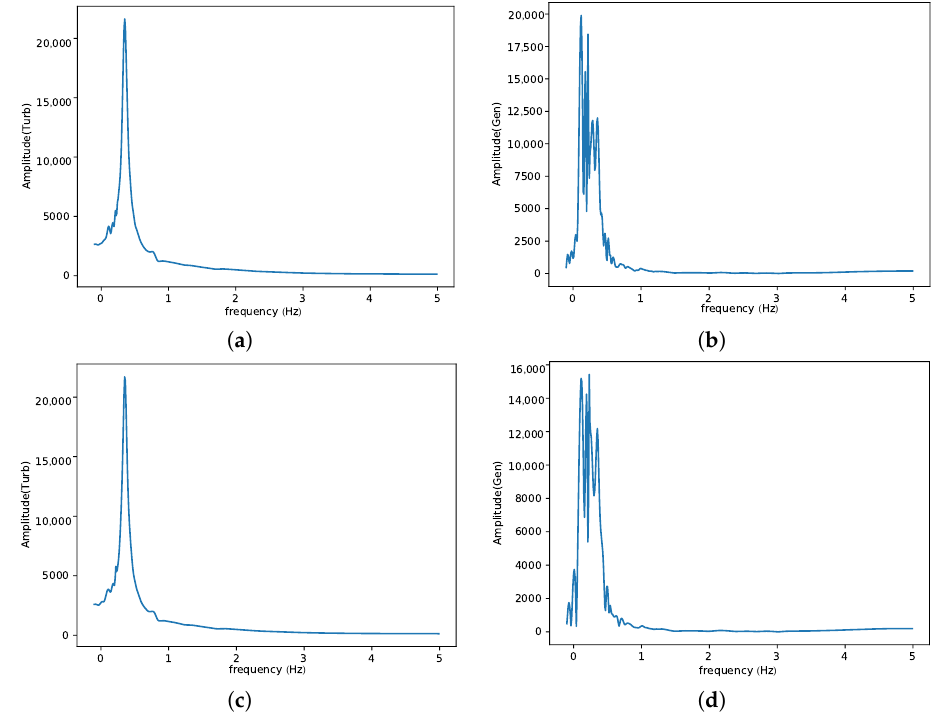
Figure 9. The effect of a smaller mesh frequency on wind turbine and generator rotational speed. ( a , b ) are the turbine and generator FFT frequency spectrum respectively for ω m = 0.05. In ( c , d ), the mesh frequency has been set to ω m = 0.5. The other parameters used for these plots are presented in Table